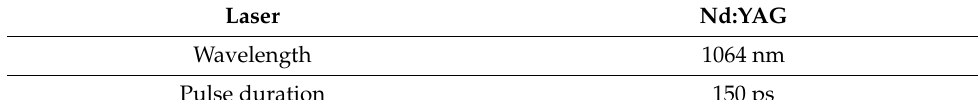
Number of accumulated pulses (N p )